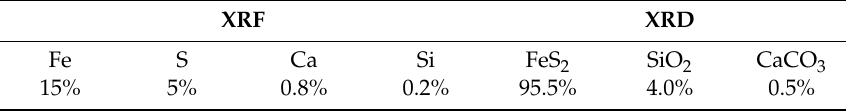
Table 1. X-ray Fluorescence (XRF) and XRD quantitative analyses of the untreated dry wood samples.